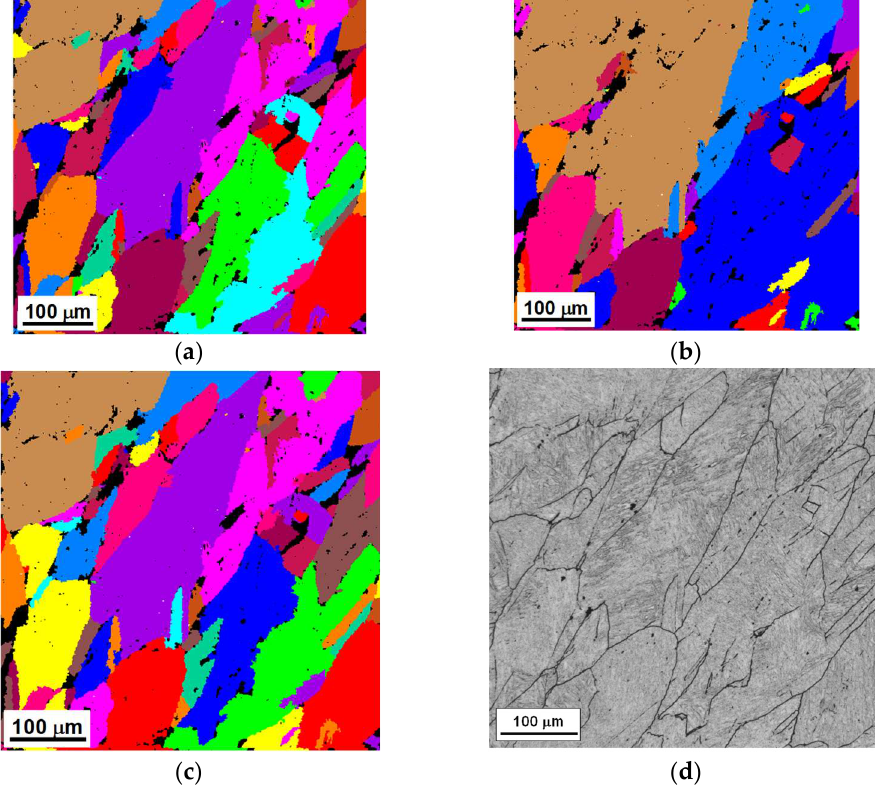
Figure 14. Unique grain colormaps obtained from the deformed austenite microstructures applying the reconstruction procedure to the martensitic scan in Figure 5a using a tolerance angle for grain boundary definition of 10 ◦ and different criteria for twin boundary exclusion: ( a ) All the high angle grain boundaries considered; ( b ) twins excluded (misorientation criterion (5 ◦ tolerance)); ( c ) twins excluded (misorientation criterion (5 ◦ tolerance) + {111} plane coincidence criterion (1 ◦ tolerance angle)) and ( d ) optical micrograph. Black areas correspond to non-reconstructed